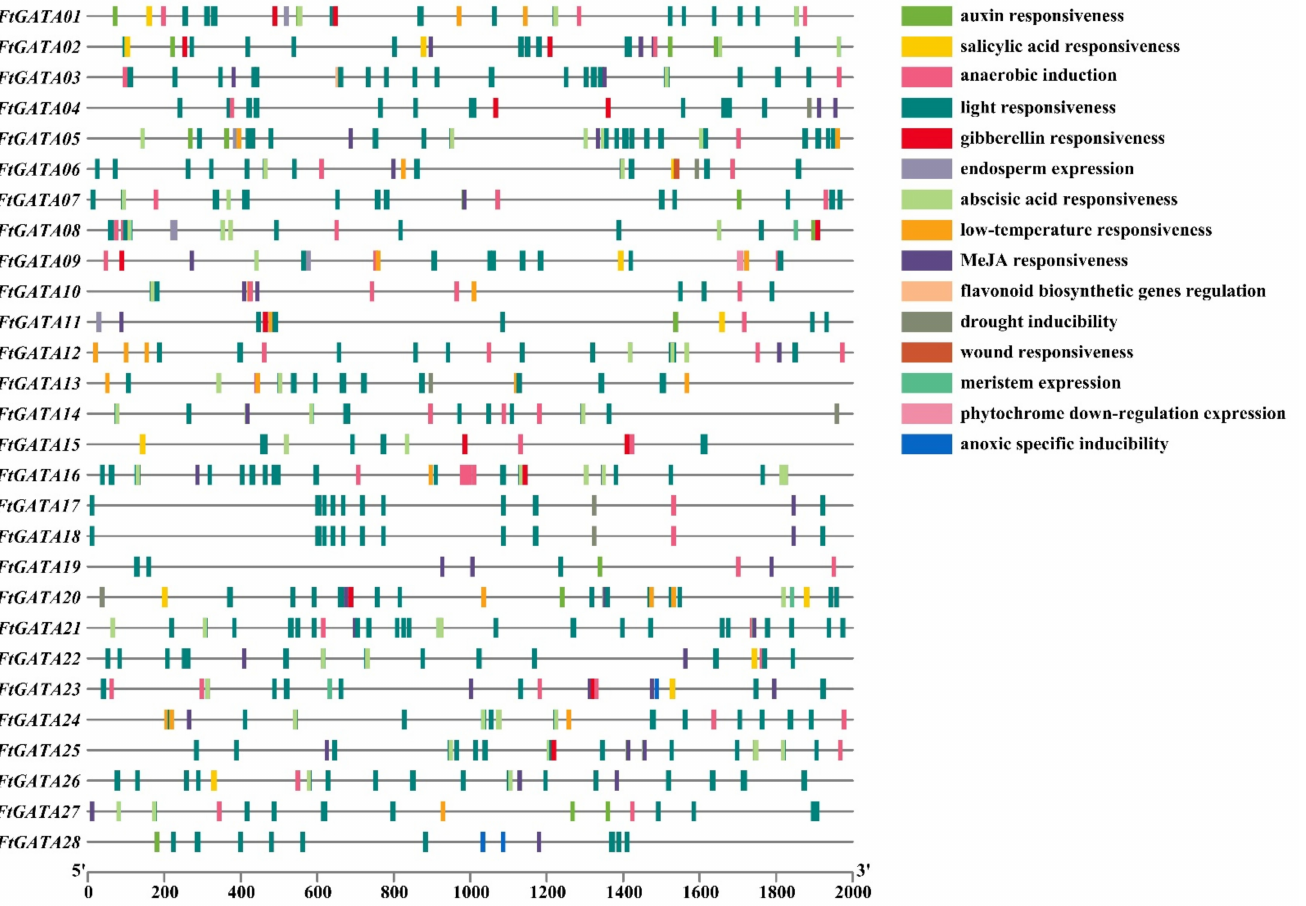
Figure 3. The cis-acting element of the promoter sequence 2000 bp upstream of 28 GATA genes in Fagopyrum tataricum